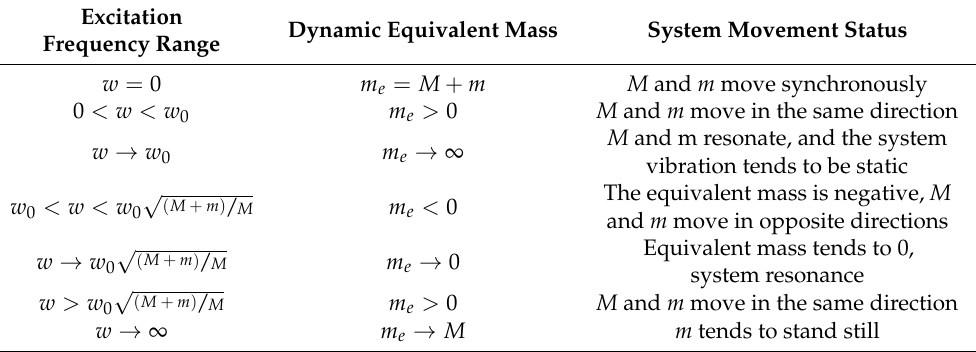
Table 1. The relationship between system dynamic equivalent mass m e and excitation frequency w .